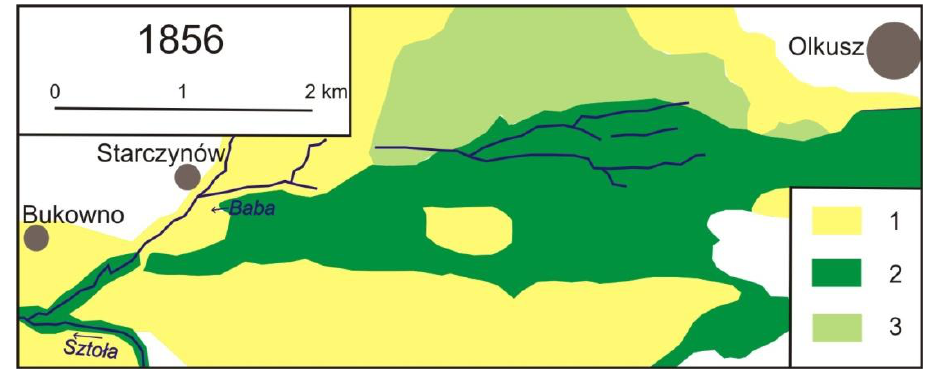
Fig. 4. Area of Starczynów „Desert” in 1856 (on the base of Karta geognostyczna Zagłębia Węglowego w Królestwie Polskim made by Hempel) 1 – sandy areas without vegetation; 2 – forests; 3 – sandy areas with rare vegetation cover